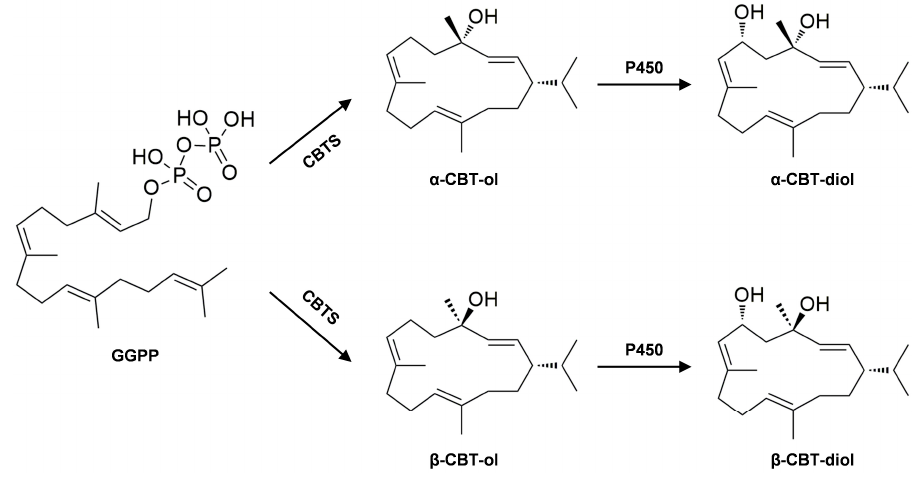
Figure 1. The biosynthetic pathways of the cembratriene-diols in tobacco [1]. GGPP, geranylgeranyl diphosphate; CBT, cembratriene.